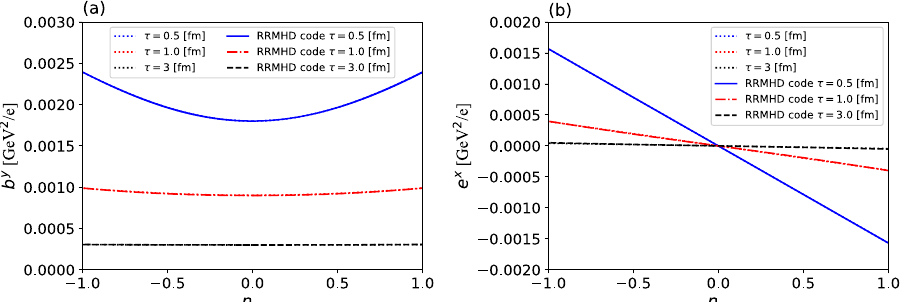
numerical results at t = 0 . 5 , 1 . 0, and 3 fm, respectively. The blue, red, and black dotted lines show the semi-analytic solutions of the a Eq. (83) and b Eq. (82) at t = 0 . 5 , 1 . 0 and 3 . 0 fm, respectively